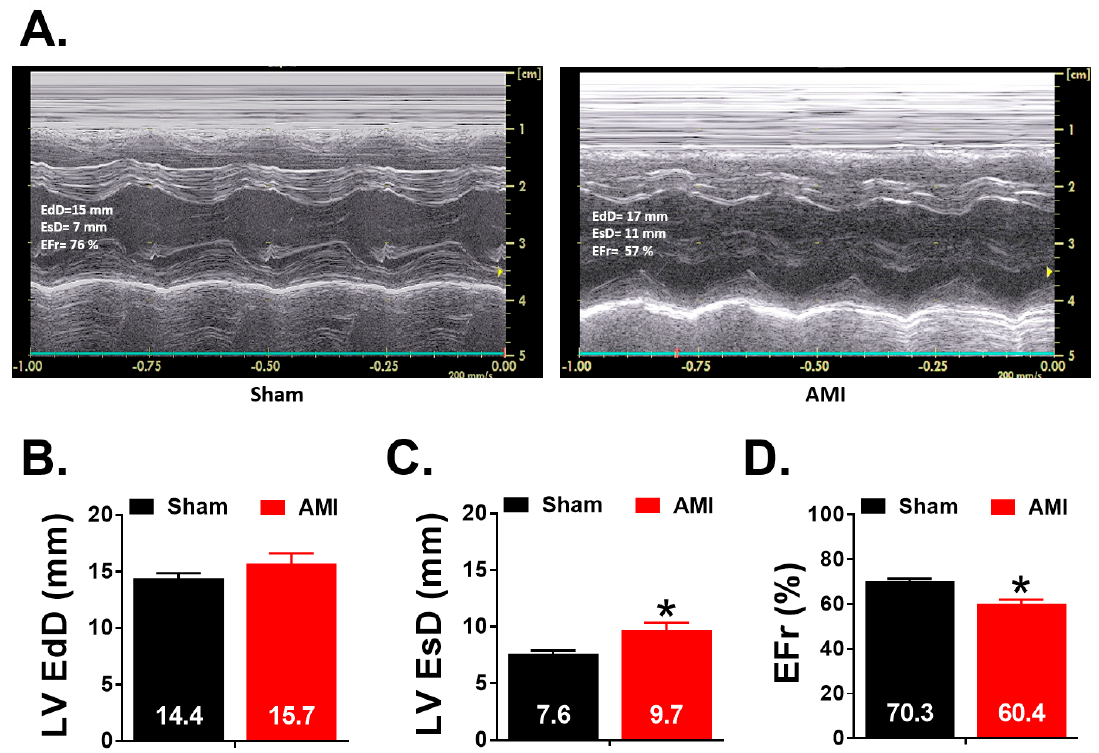
Figure 8. ( A ) M mode recordings of the left ventricle obtained in one experiment of sham group and another of AMI group. ( B – D ) Echocardiographic parameters obtained in week 5 in both experimental groups (sham and AMI): left ventricular end diastolic (LV EdD) and systolic (LV EsD) diameters and left ventricle ejection fraction (EFr). * p < 0.05 compared with sham group. Error bars = standard error of mean.